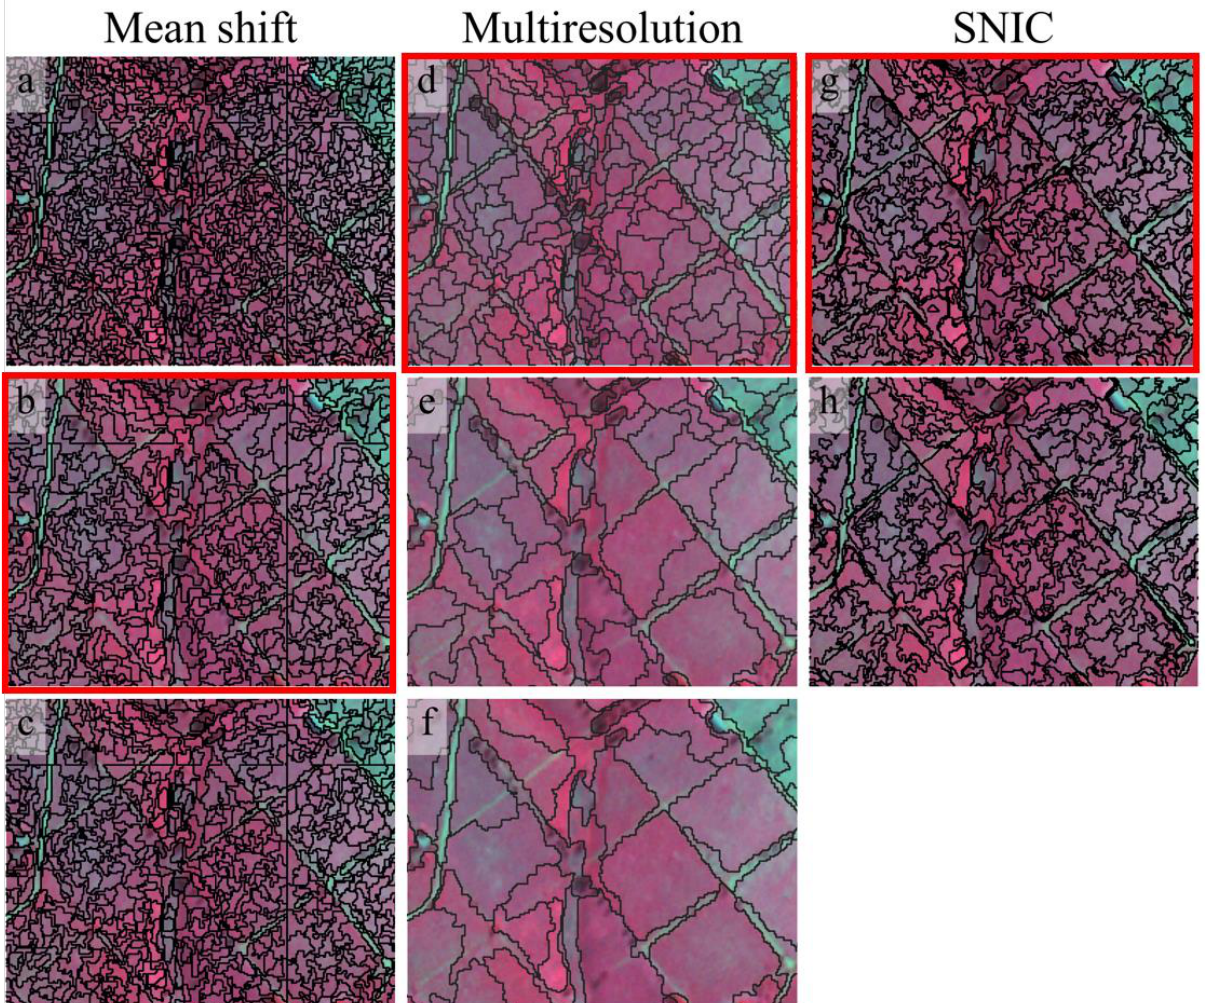
Figure 3 . Segmentation results for medium farms. (a) Mean shift: range radius = 5, minimum region size = 20; (b) Mean shift: range radius = 5, minimum region size = 60; (c) Mean shift: range radius = 15, minimum region size = 40; (d) Multiresolution: SP = 20, shape: 0.8, compactness: 0.5; (e) Multiresolution: SP = 46, shape: 0.8, compactness: 0.5; (f) Multiresolution: SP = 75, shape: 0.8, compactness: 0.5; (g) SNIC: with size = 3, compactness = 0, connectivity = 8, neighborhood size = 256, seed grid size = 12; (h) SNIC: with size = 3, compactness = 0, connectivity = 8, neighborhood size = 256, seed grid size = 14. The best performing set of parameters for each algorithm is highlighted by a red square (b: mean shift, d: multiresolution, g: